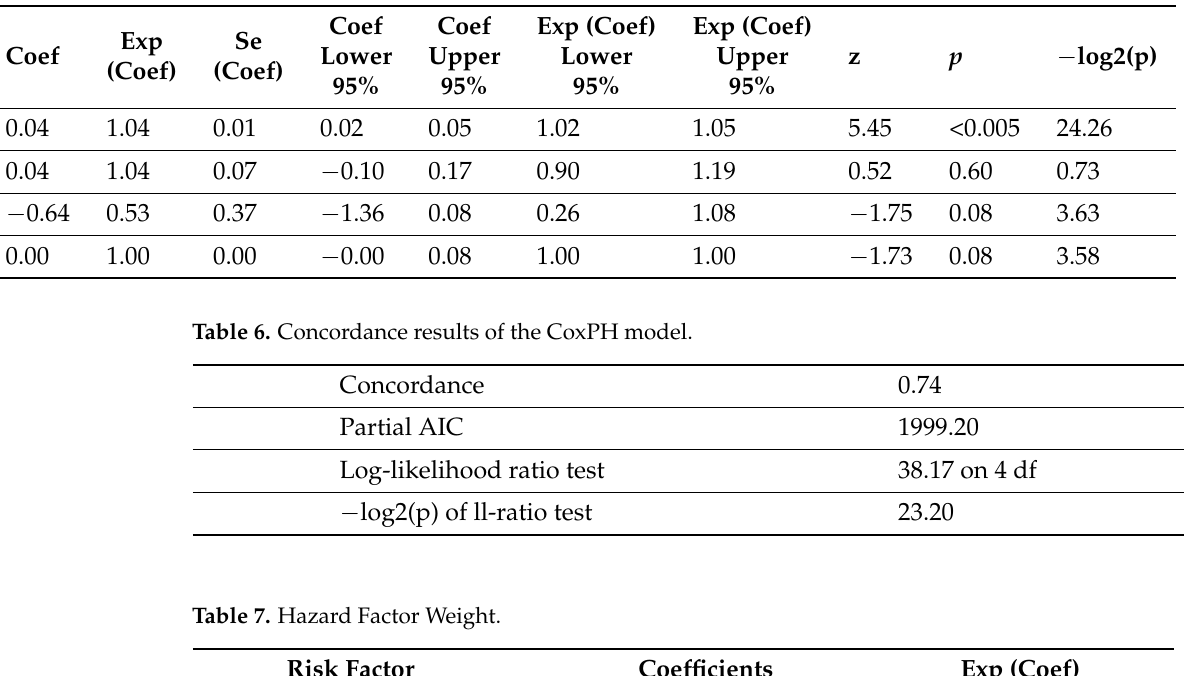
Table 5. The parameter coefficient values from the CoxPH model.